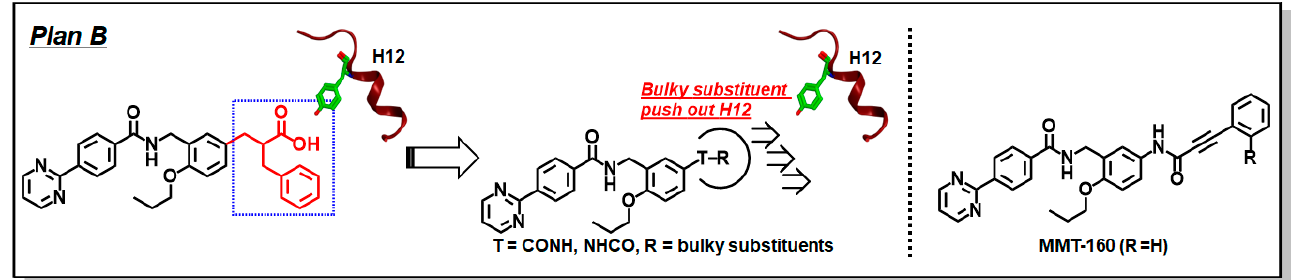
Figure 6. The strategic plan B to create hPPAR γ antagonists.